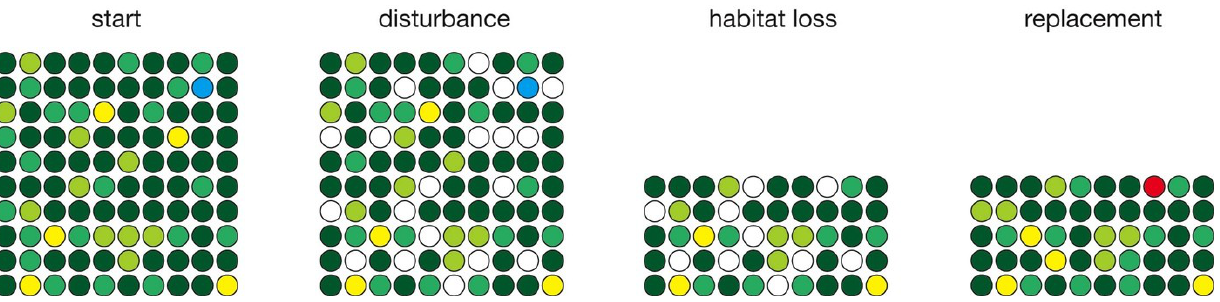
Figure 2. Simulation of habitat loss, with the normal disturbance and replacement steps separated by an additional phase in which a given fraction of sites are